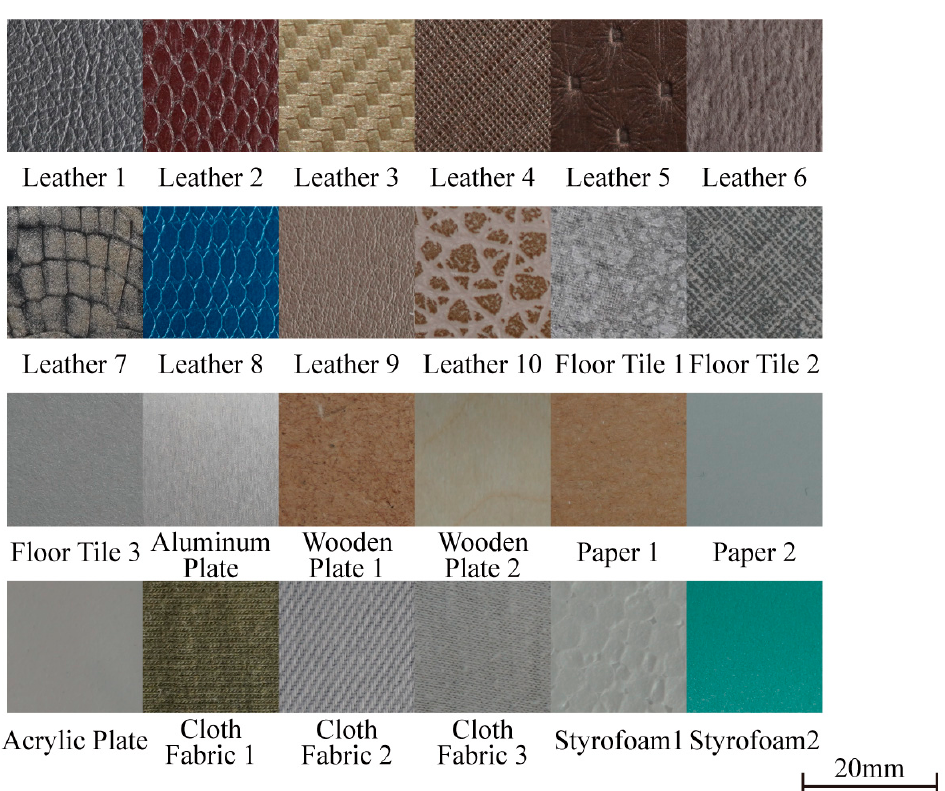
Figure 2. Twenty-four types of textures used for the experiment, including ten types of leather, three types of ceramic floor tiles, an aluminum plate, two types of wooden plate, two types of paper, an acrylic plate, three types of cloth fabric, and two types of Styrofoam. These 24 textures were selected based on their surface pattern, hardness, roughness, and friction. Each image corresponds to a 20 mm × 20 mm area of the texture surface. A scale bar of 20 mm is displayed in the lower left corner.